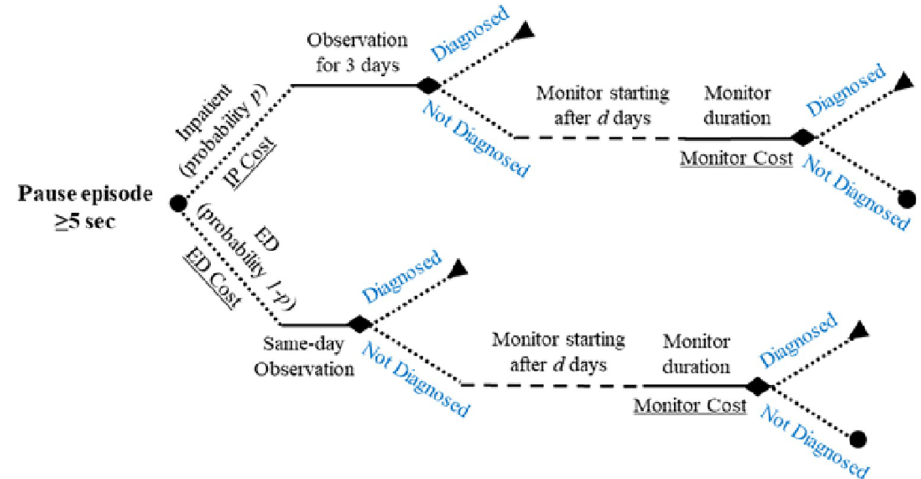
Fig 1. Simulation decision tree. Abbreviations: Diag = diagnosed; ED, emergency department; IP, inpatient.